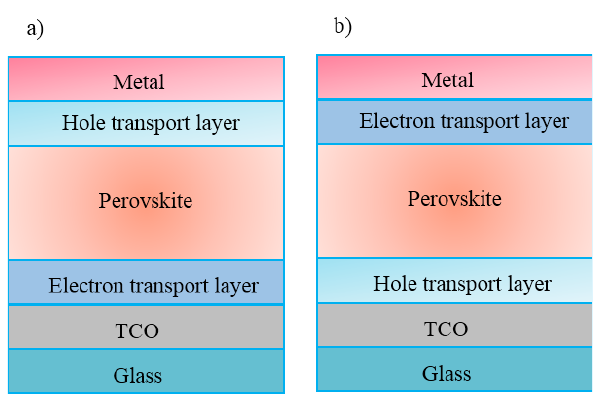
Figure 5: Perovskite solar cell structures a), b) n-i-p and p-i-n config-